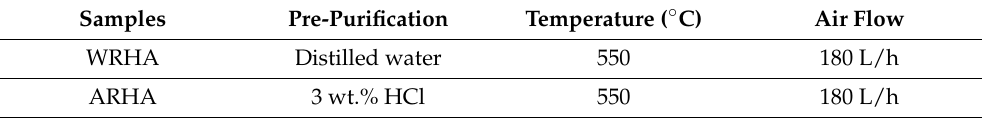
Table 1. The production conditions of the two kinds of filler